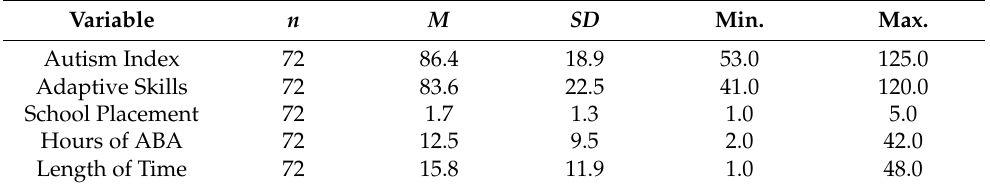
Table 3. Descriptive Statistics for Predictor and Outcome Variable.